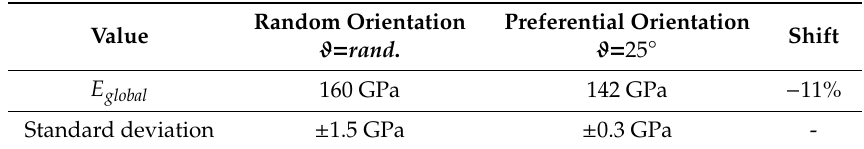
Table 3. Comparison of the determined global Young’s moduli from polycrystalline Finite Element Analysis (FEA). Random Orientation Value ϑ = rand